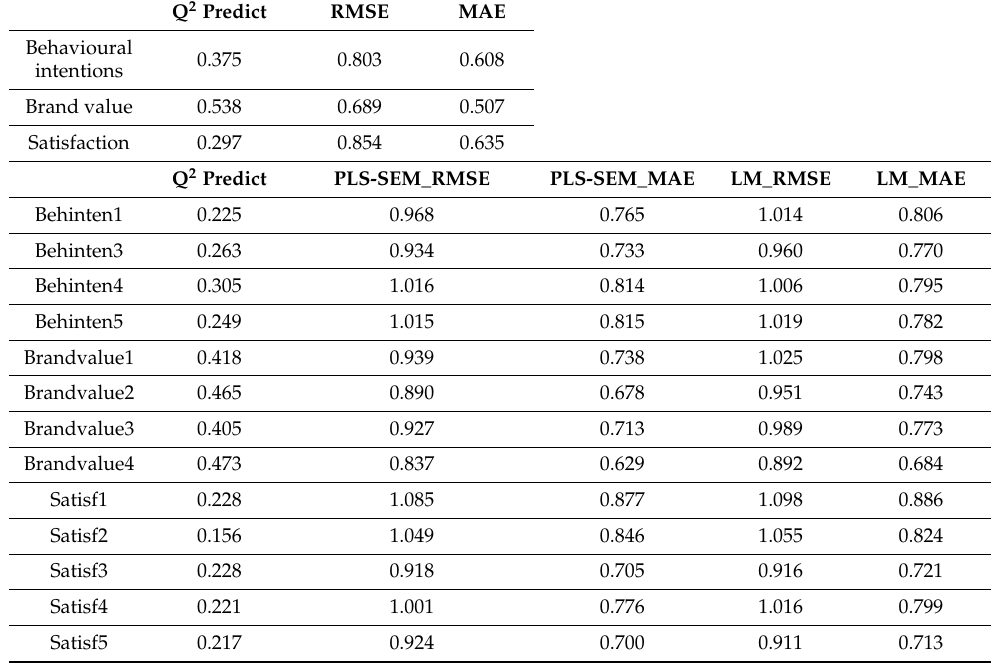
Table 9. PLS predict